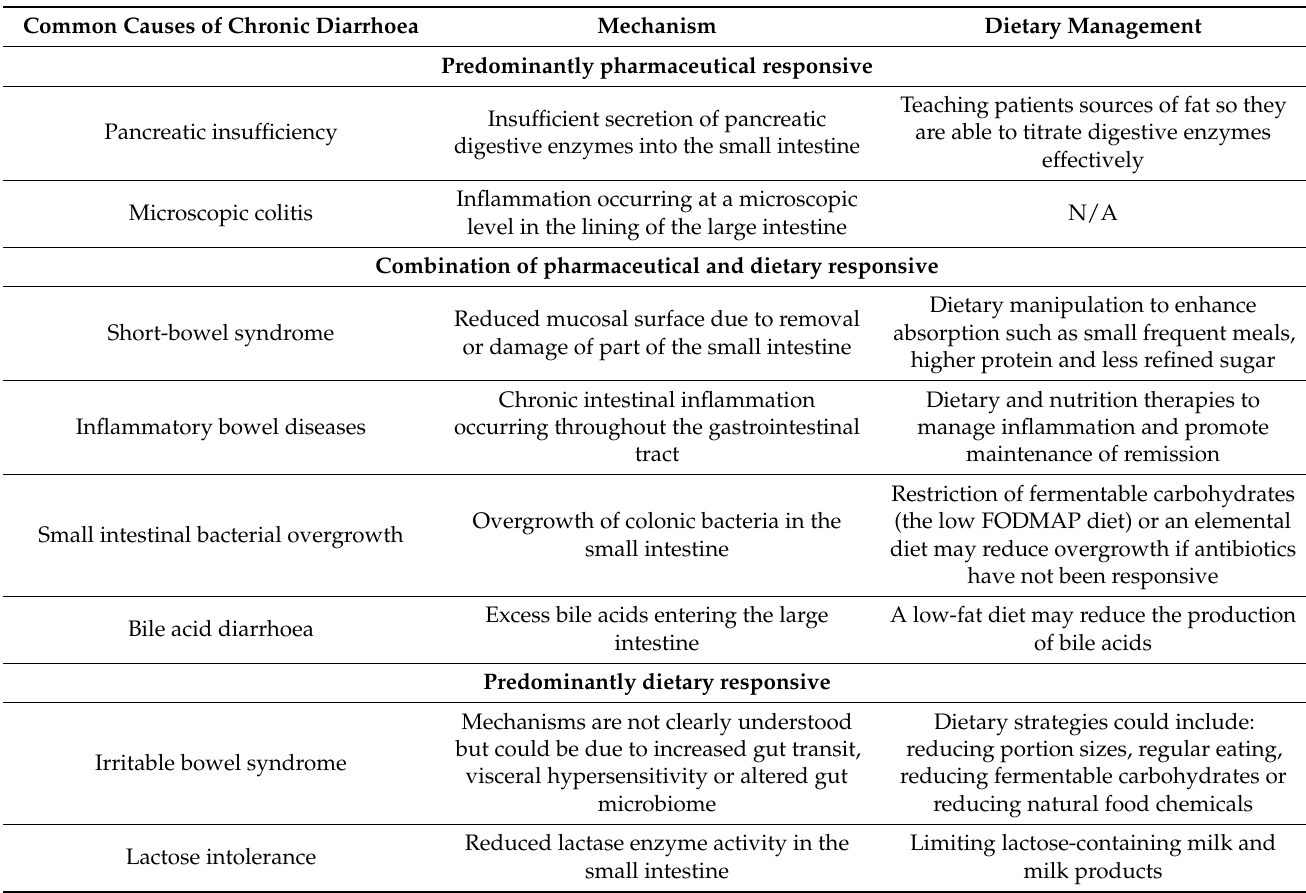
Figure 1. Evidence-based approaches for the management of chronic diarrhoea. Table 2. Common causes of chronic diarrhoea—pharmaceutical and dietary